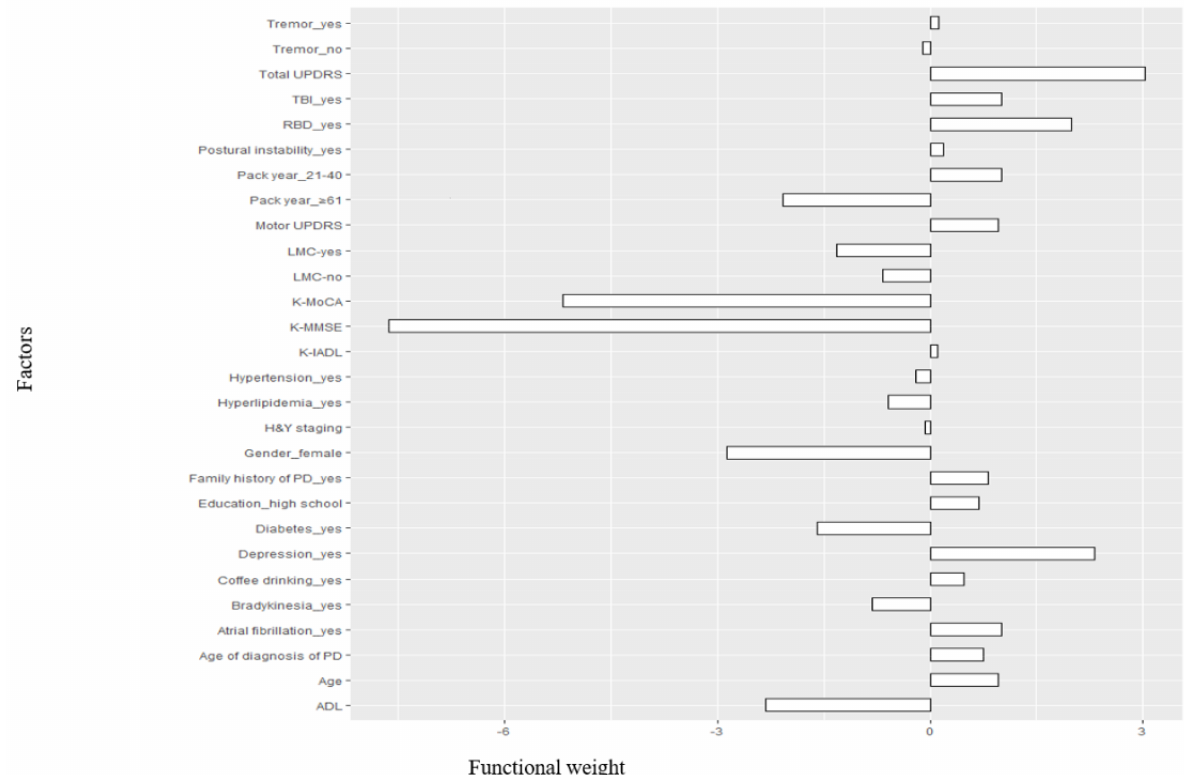
Figure 3. Functional weights of the major variables in the Nu-SVR-RBF